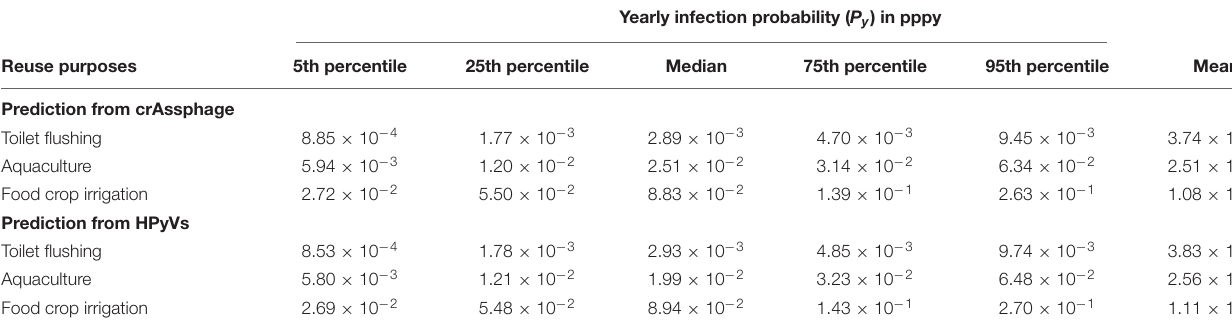
TABLE 2 | Yearly infection probability ( P y ) of human adenovirus types 40 and 41 (HAdV40/41) predicted from crAssphage and HPyVs. Yearly infection probability ( P y ) in pppy